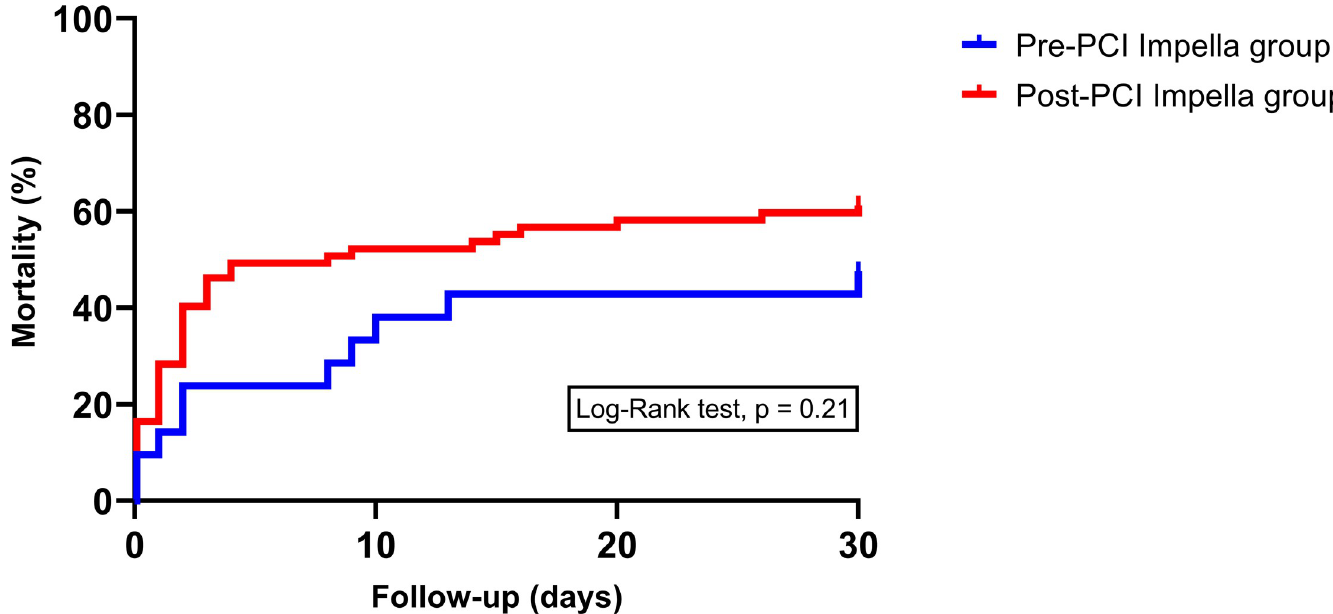
Fig 1. Short term all-cause mortality in AMICS patients treated with primary PCI and pre- versus post-PCI Impella support.